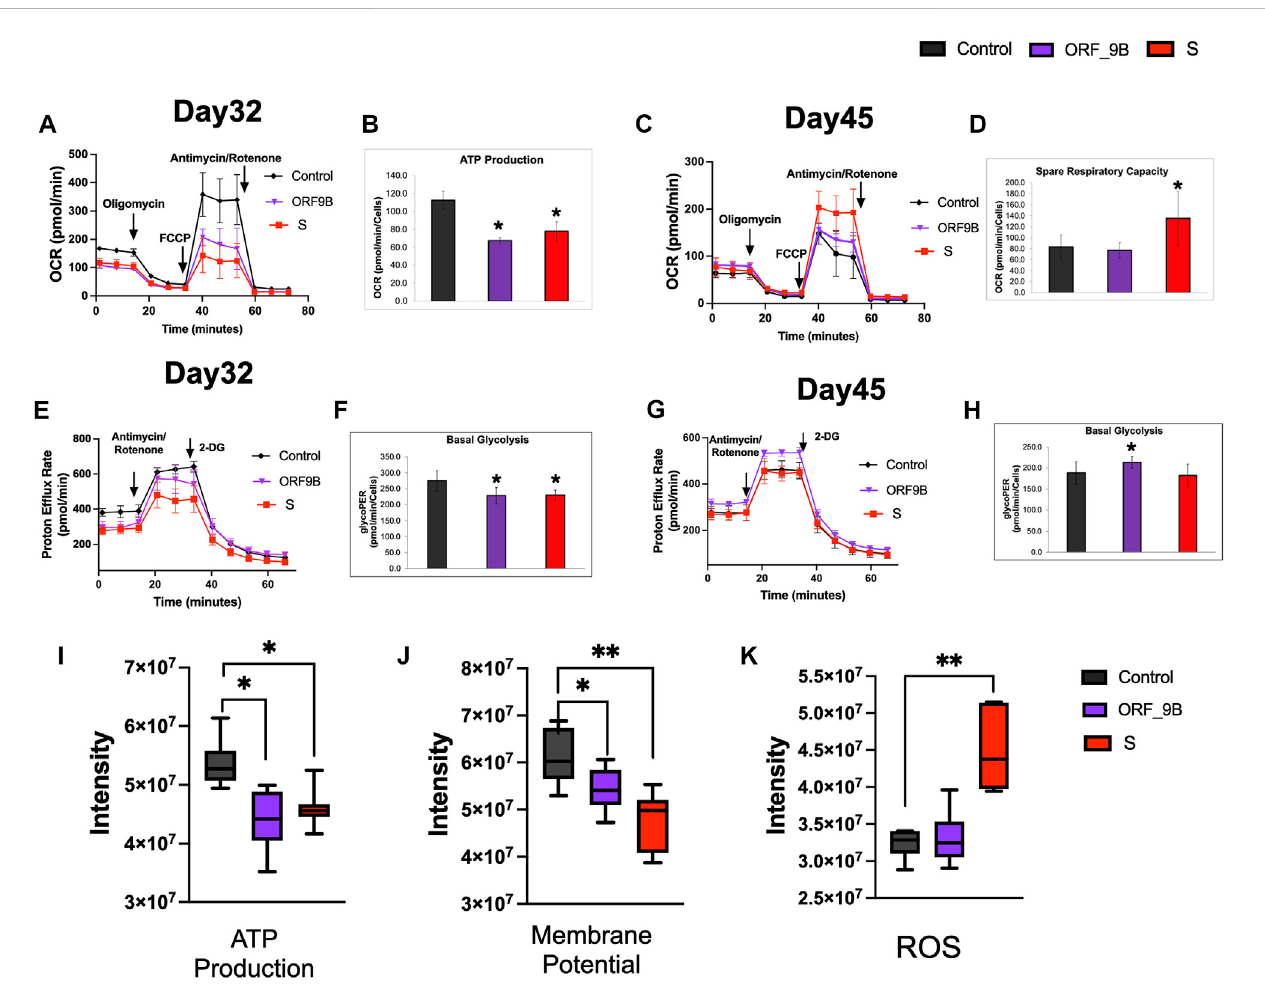
EvaluationoftheeffectsofSARS-CoV-2subunitsonmitochondrialfunctionsandglycolysis. (A,B) Evaluationofmitochondrialoxygenconsumptionrate (OCR) in CMs on day 32 after overexpression of S and ORF-9B subunits for two days. (C, D) Evaluation of mitochondrial oxygen consumption rate (OCR) in CMsonday46afteroverexpressionoftheSandORF-9Bsubunitsfortwoweeks. (E,F) Evaluationofglycolysisbymeasuringprotonef fl uxrate(PER)inCMson day 32 after overexpression of the S and ORF-9B subunits for 2 days. (G, H) Evaluation of glycolysis by measuring PER in CMs on day 45 after overexpression of S and ORF-9B subunits for 2 weeks. The data were normalized to cell numbers. (H – K) Mitochondrial ATP production (I) , mitochondrial membranepotential (J) ,andreactiveoxygenspecies(ROS)levelinCMsweremeasuredwithaBioTekCytation1.Dataarereportedasmeans±standarderror of the mean (SEM). p < 0.05: **, p <